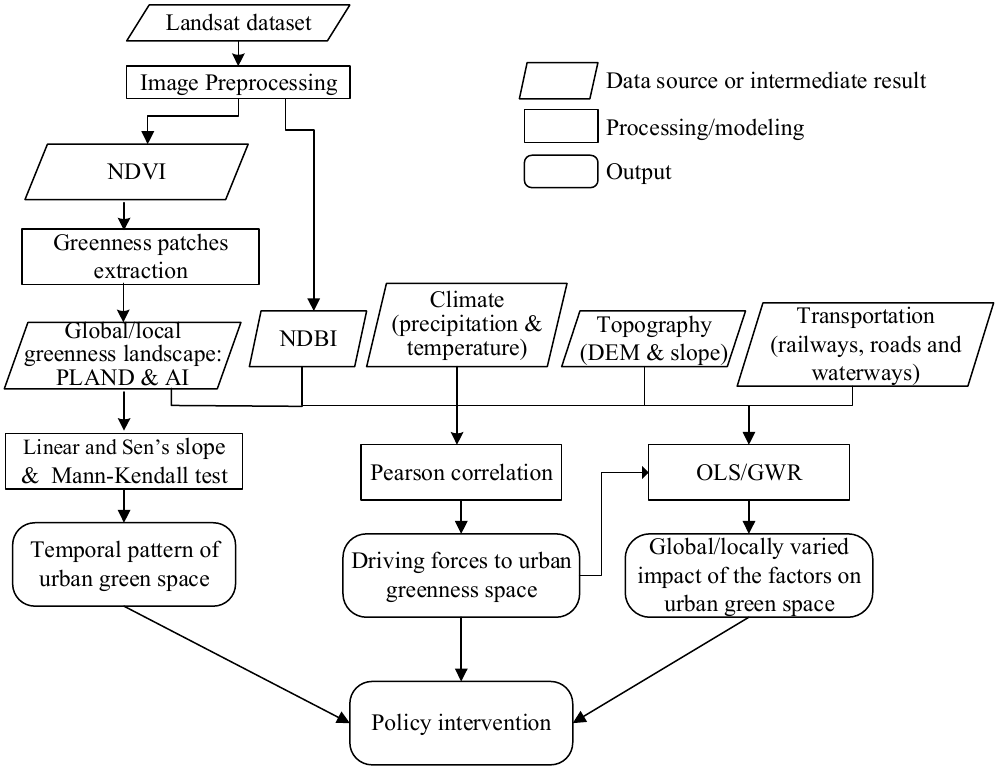
Figure 2. The flowchart of the study schema.